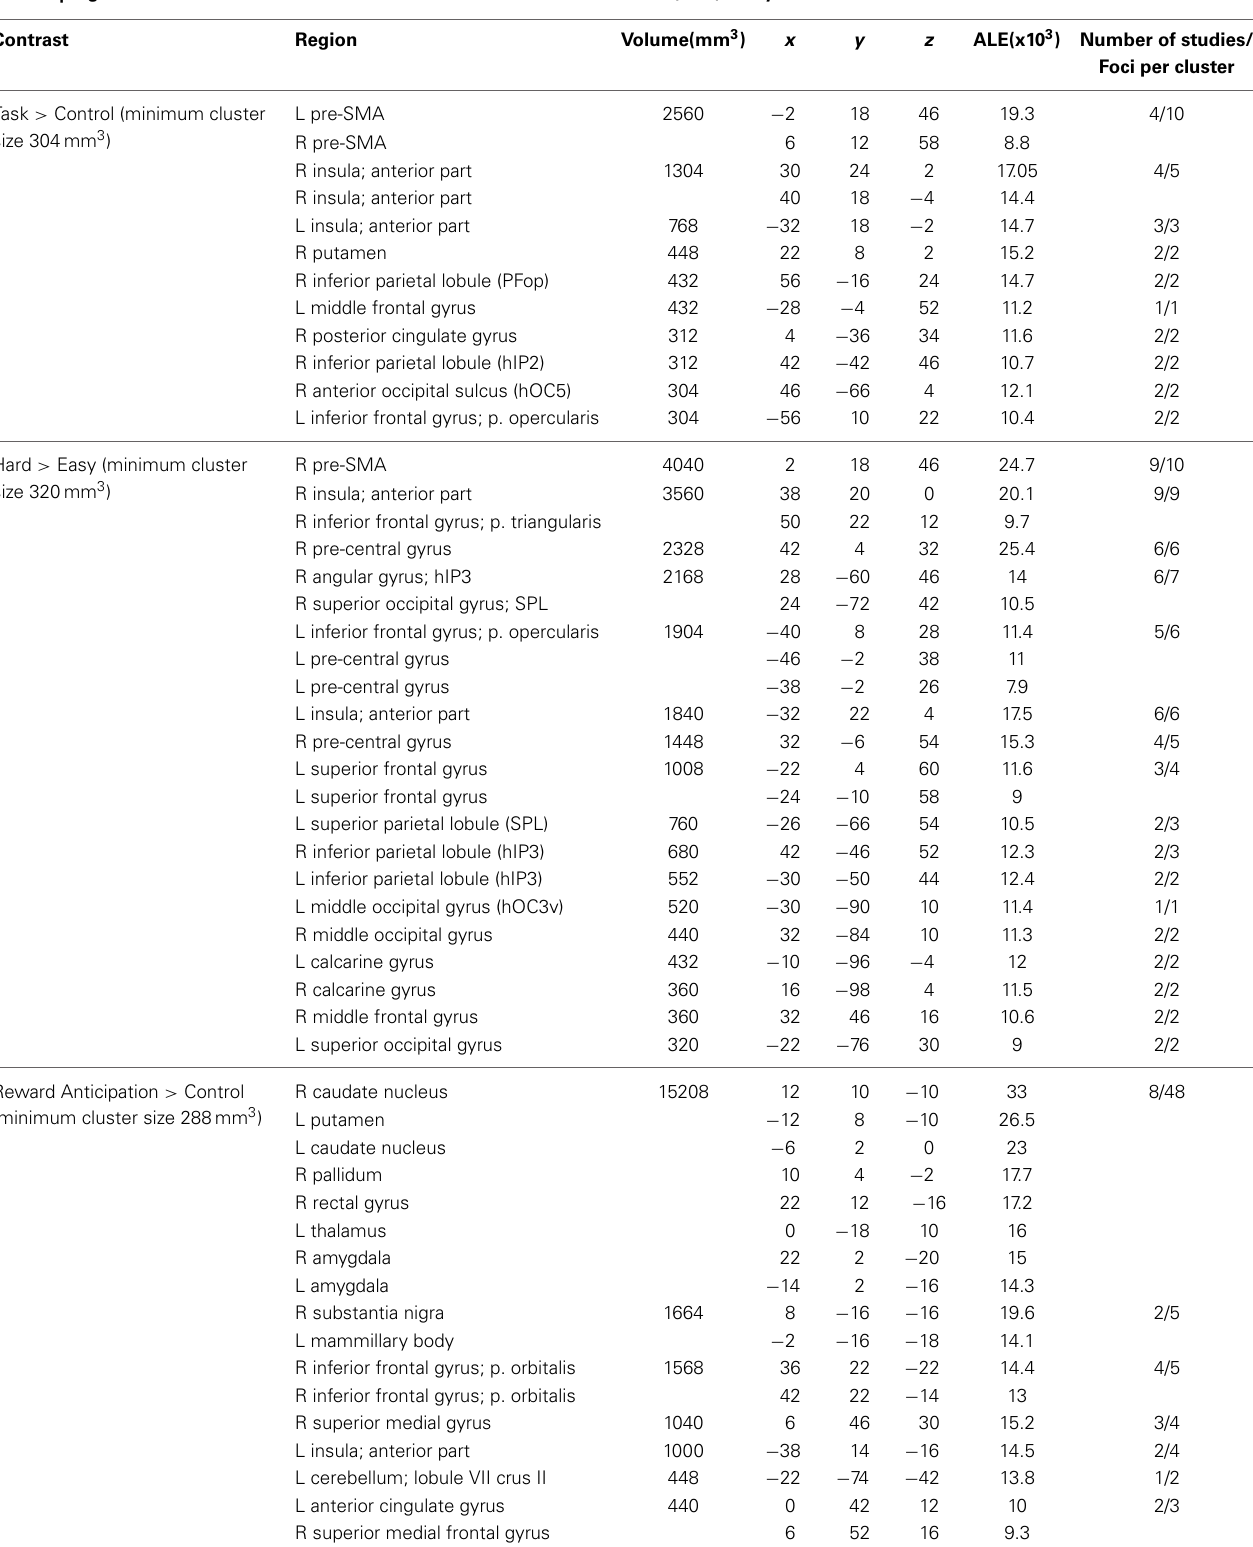
Table 4 | Significant activation clusters of the Activation Likelihood Estimate (ALE) analyses.